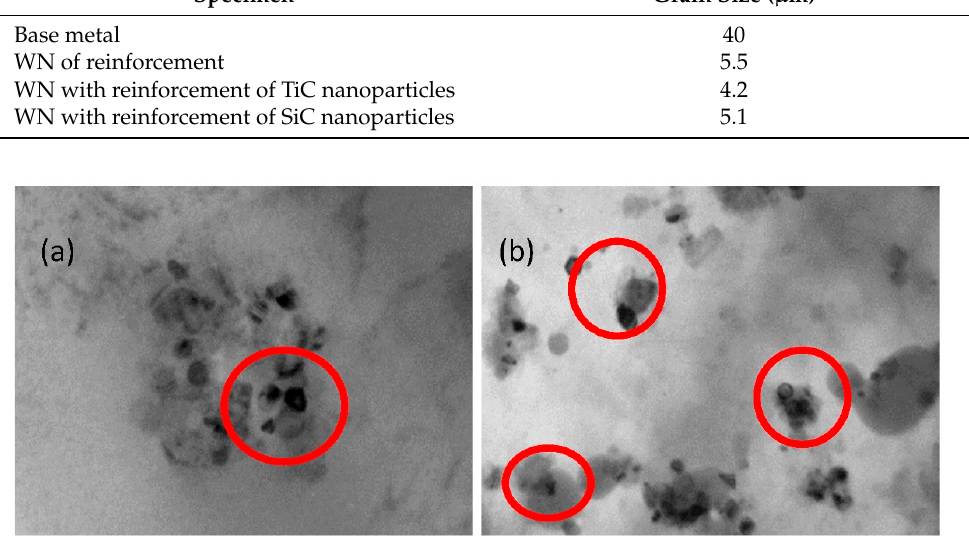
Figure 11. No agglomeration (200 nm) of ( a ) SiC and ( b ) TiC nanoparticles in the weld nugget (WN) [40] . Table 2. Grain size in the weld nugget.